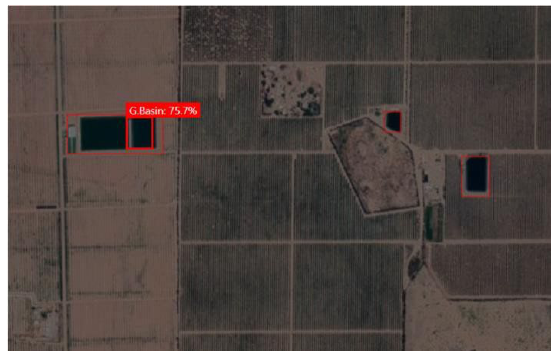
Figure 10. YOLO model